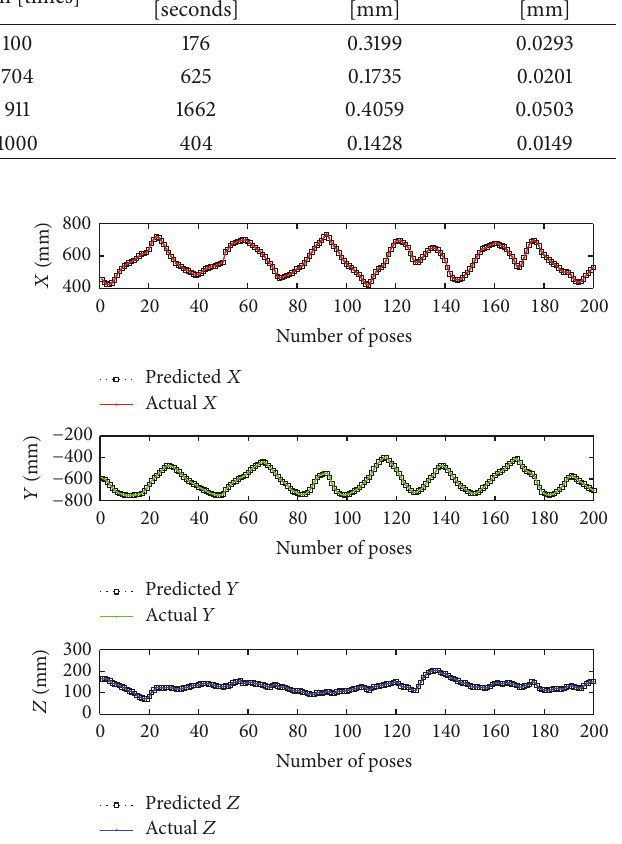
Figure 7: The prediction coordinates of the BPNN model for the AACMM.